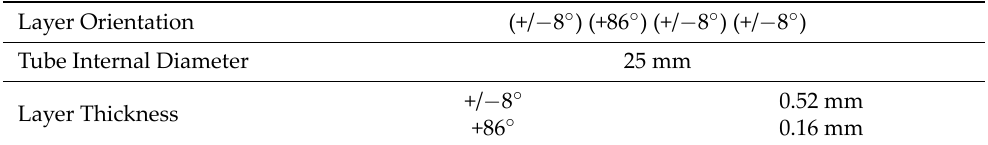
Table 1. CFRP Composite Tube